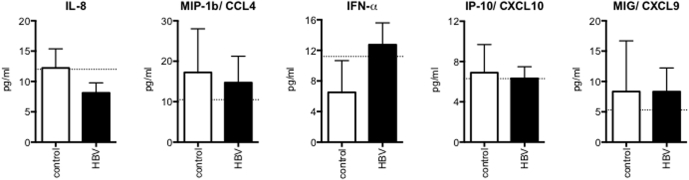
Biomarker expression patterns in HBV-infected and control HUHEP mice. Plasma from control (n=4) and HBV-infected (n=10) mice at the time of sacrifice (20 ±2 wpi) was analyzed by multiplex assay for human cytokines. IL-1b, IL-2, IL-2R, IL-4, IL-5, IL-6, IL-10, IL-12, IL-13, IL-15, IL-17, CCL2, CCL3, CCL5, GM-CSF, IFN-γ, and TNF-α were not detected. Dotted lines indicate the lower limit of quantification for each assay.